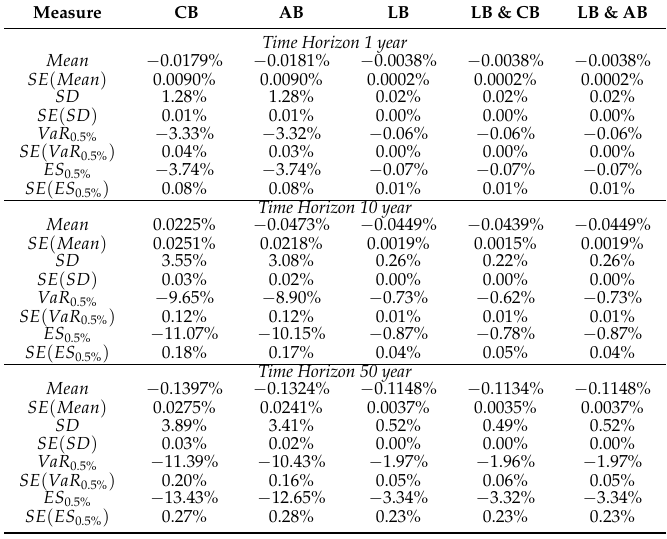
Table 15. Summary Statistics for Surplus—Delta-Gamma